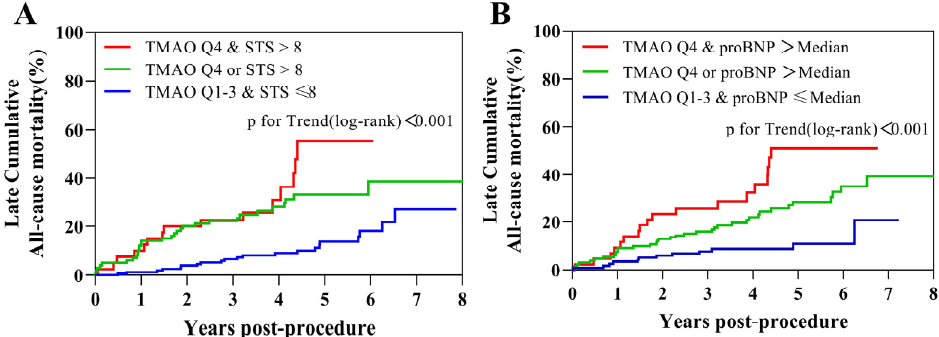
Figure 3. Late cumulative all-cause mortality according to combinations of TMAO and STS or proBNP. Kaplan–Meier survival analysis for late cumulative all-cause mortality stratified by ( A ) combinations of TMAO and STS score and ( B ) combinations of TMAO and proBNP, reporting none, one, or both elevated. TMAO above 6.91 µ mol/L (Q4), proBNP above 2871 pg/mL (median), STS score above 8 (high risk), respectively. TMAO = Trimethylamine N-oxide; STS = Society of Thoracic Surgeons; proBNP = N-terminal prohormone of brain natriuretic